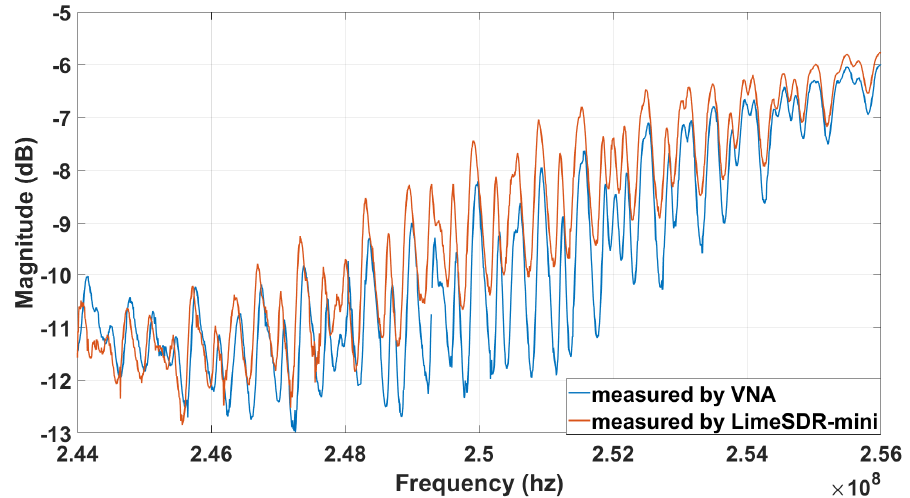
Figure 12. Magnitude response in the frequency domain measured by VNA and LimeSDR−mini from 244 MHz to 256 MHz.